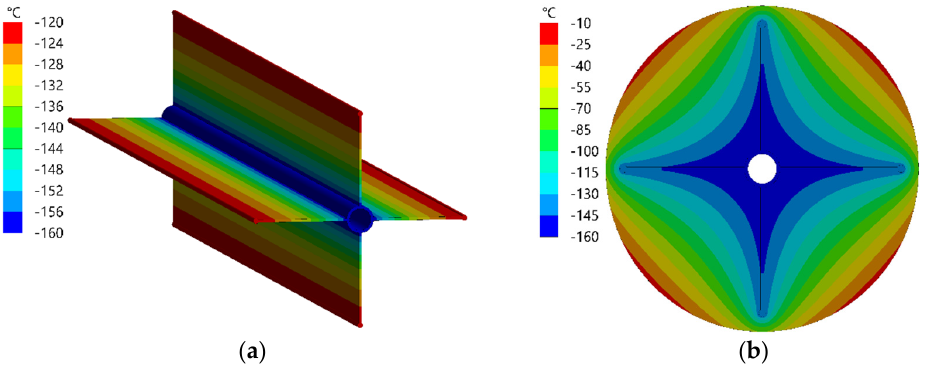
Figure 8. Temperature distribution: ( a ) 4 fins—no frost, ( b ) 4 fins with frost.